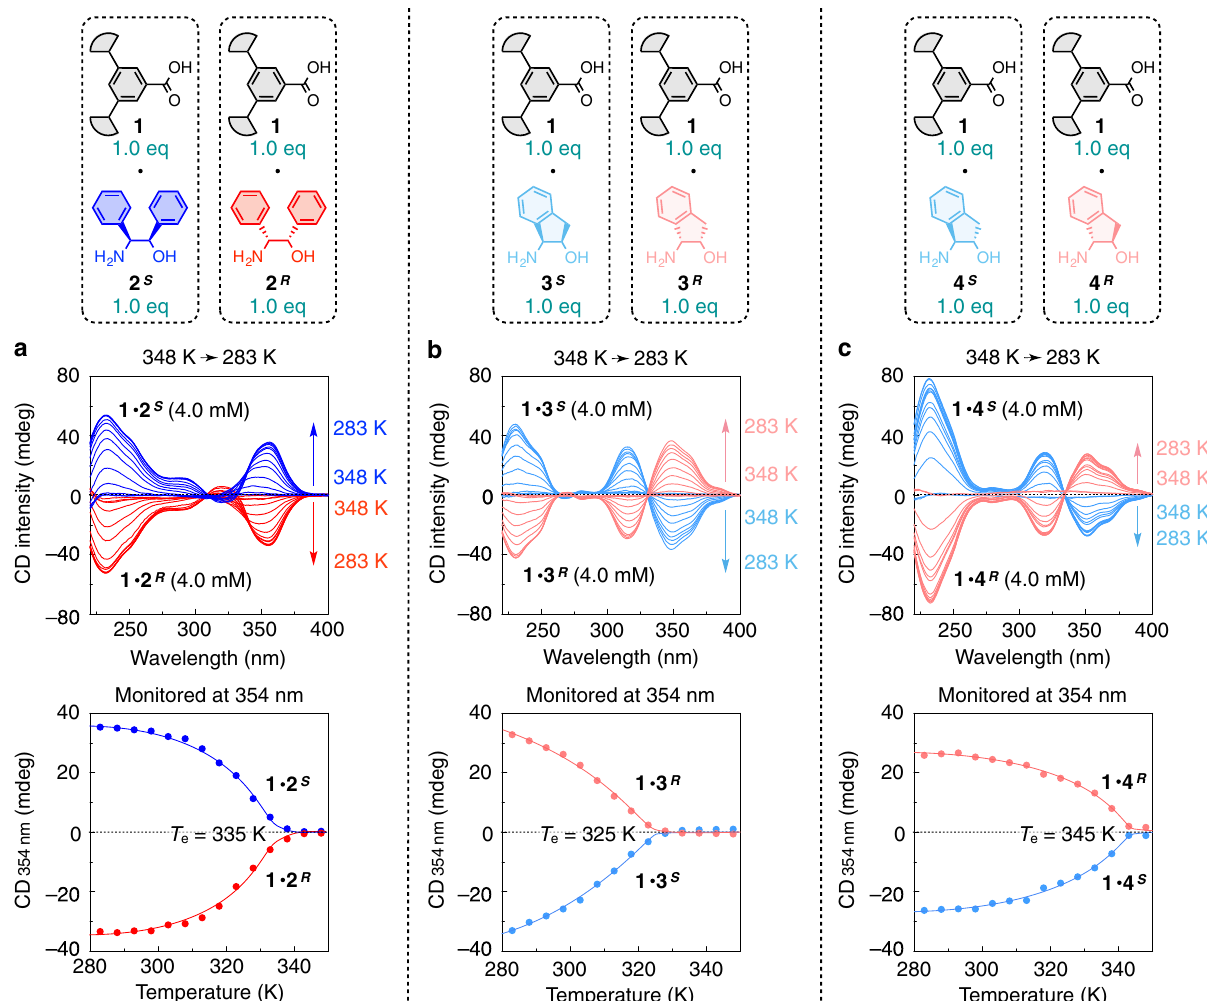
Fig. 3 Elongation pro fi les of the helical supramolecular polymers upon cooling. a – c Variable-temperature CD pro fi les at every 5 K step of 1 ∙ 2 S / 1 ∙ 2 R ( a ), 1 ∙ 3 S / 1 ∙ 3 R ( b ), and 1 ∙ 4 S / 1 ∙ 4 R ( c ) in dodecane (4.0 mM) measured upon cooling from 348 to 283 K at – 1.0 K/min. CD spectra (upper) and cooling curves monitored with CD intensity at 354 nm